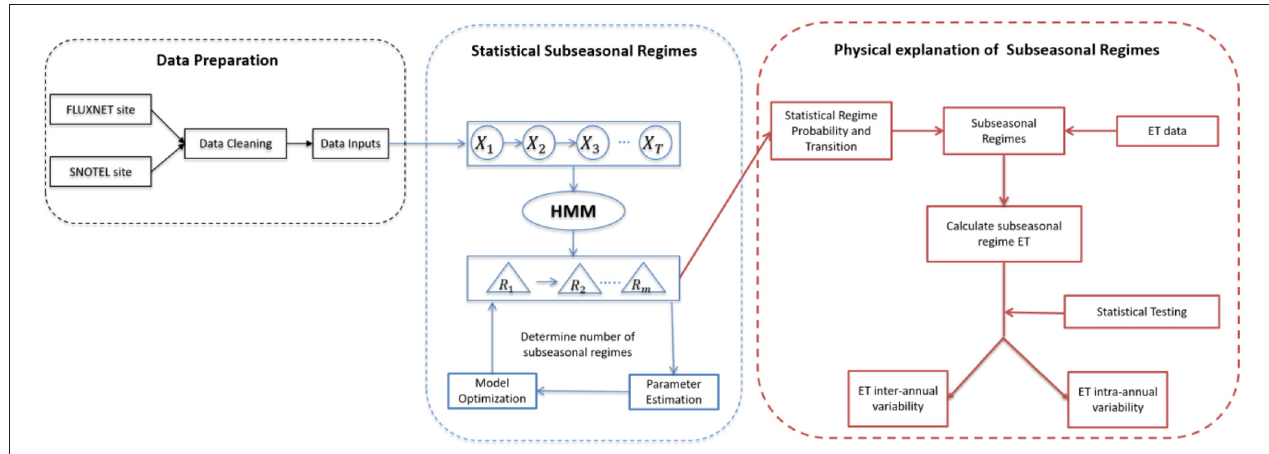
FIGURE 2 | Schematic steps for the subseasonal regime